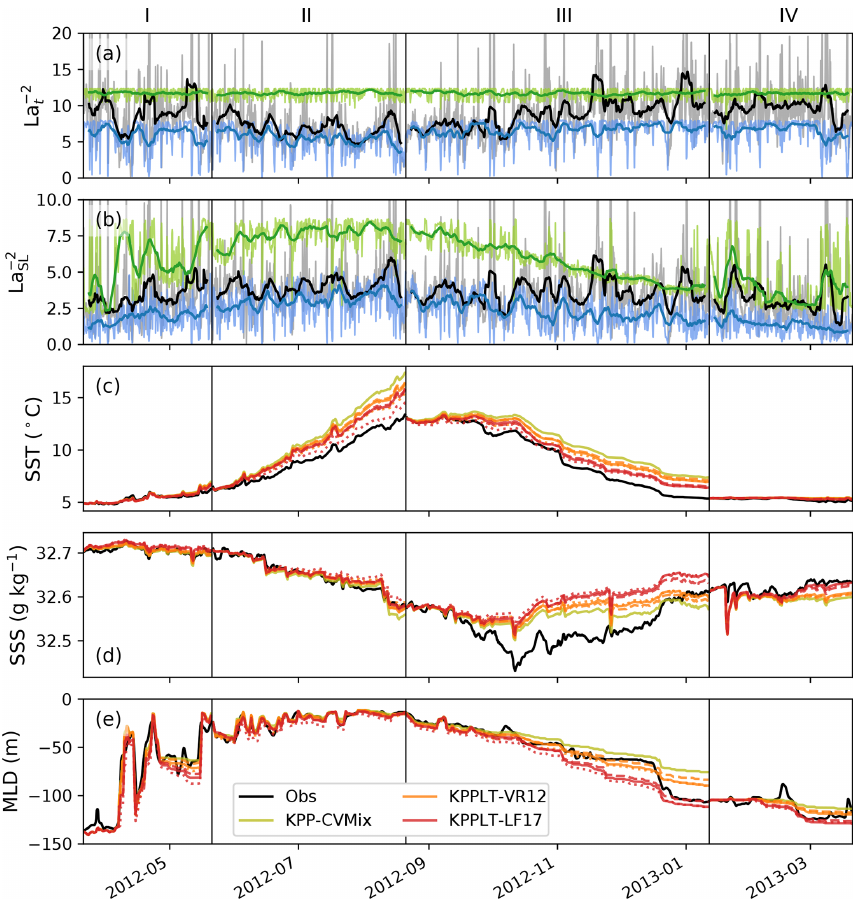
Figure 8. Time series of (a) La − 2 t , where La t is the turbulent Langmuir number, (b) La − 2 , where La SL is the surface-layer-averaged SL Langmuir number, (c) sea surface temperature (SST; ◦ C), (d) sea surface salinity (SSS; gkg − 1 ), and (e) MLD (m) defined by a temperature threshold method following de Boyer Montégut et al. (2004) at Ocean Station Papa. In panels (a) and (b) , the thin line in gray shows the 3-hourly time series and the thick line in black shows the 5d moving average estimated from the wave spectrum using Eq. (4). The blue lines show the same for the “theory wave” estimate of Stokes drift following Li et al. (2017) and green lines for the exponentially decaying Stokes drift assuming La t ≈ 0 . 3 and δ S = 5m. Solid lines in panels (c) – (e) show the same results as in panels (e) – (g) of Fig. 4. Dashed lines show the results with Stokes drift estimated from the “theory wave” approach. Dotted lines show the results with the idealized exponential Stokes